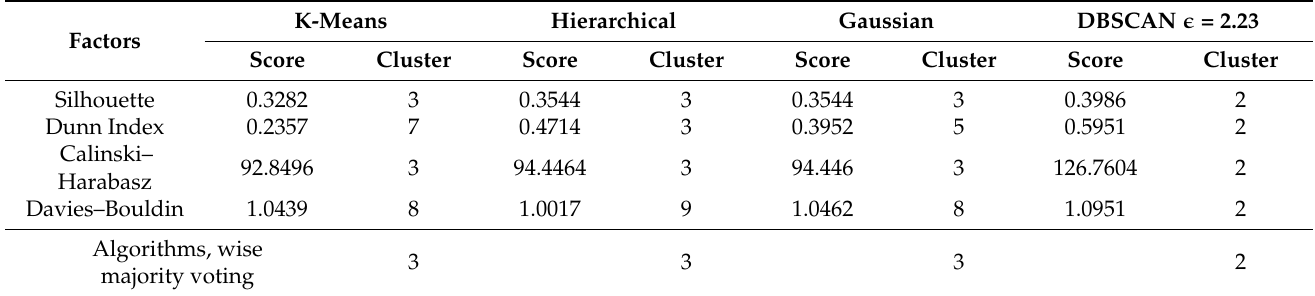
Table 4. Clusters factors analysis scores of the corresponding cluster for different